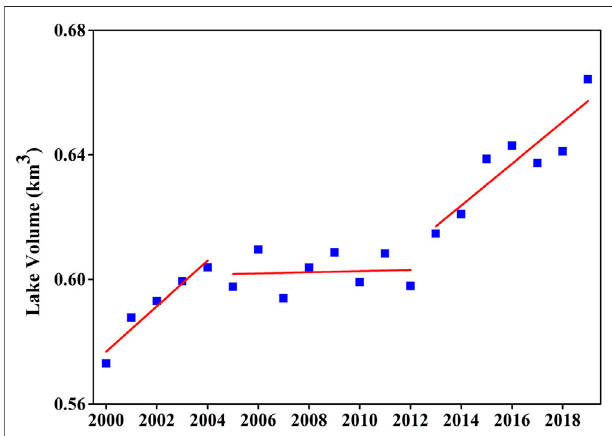
FIGURE 6 | Changes in glacial lake water volume from 2000 to 2019.